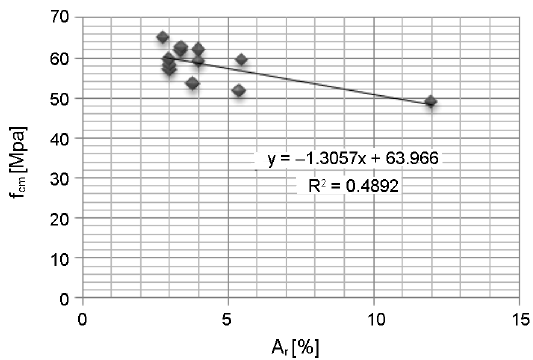
Fig. 7. The relationship between the air volume in a mix and the compressive strength of hardened mortar